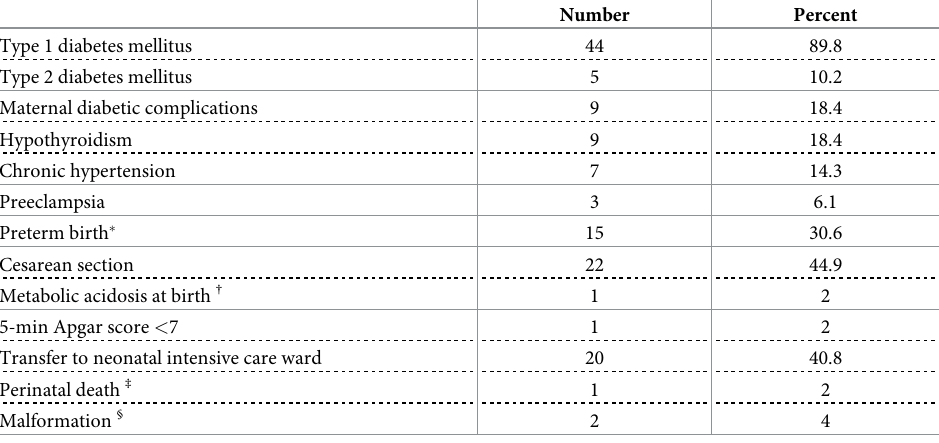
Table 1. Maternal and neonatal characteristics and outcomes in the study population of 49 pregnancies with preg- estational diabetes mellitus.